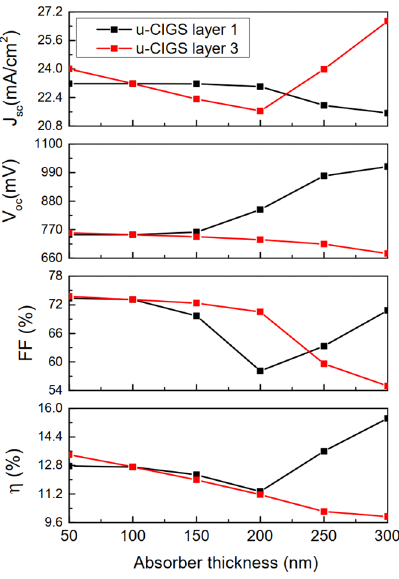
Figure 15. Schematic structure of ultrathin CIGS solar cell with three sub-layers.